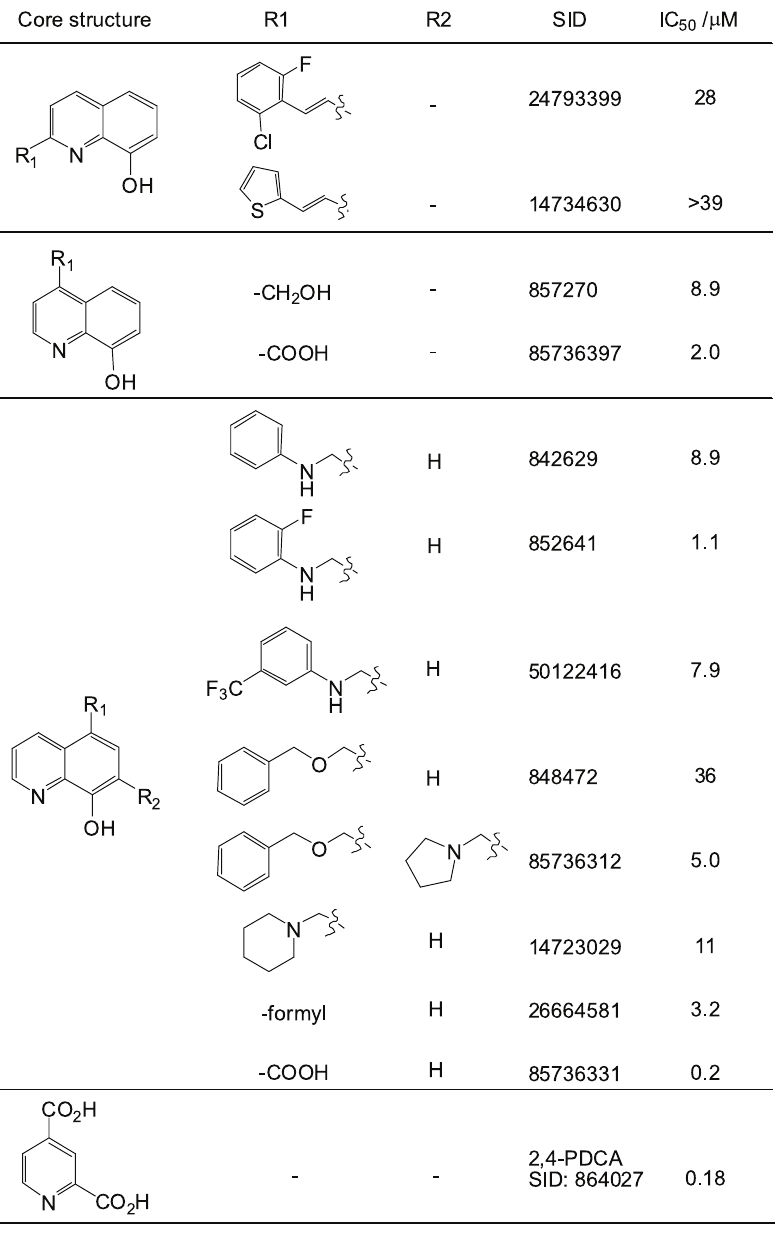
Figure 3. Structure-activity relationships for substituted 8-hydroxyquinolines identified in the qHTS against JMJD2E (qHTS IC 50 values derived from the FDH-coupled assay). Some substitution patterns were chosen for further medicinal chemistry; IC 50 s for these synthesized compounds are indicated in italics. doi:10.1371/journal.pone.0015535.g003 PLoS ONE |